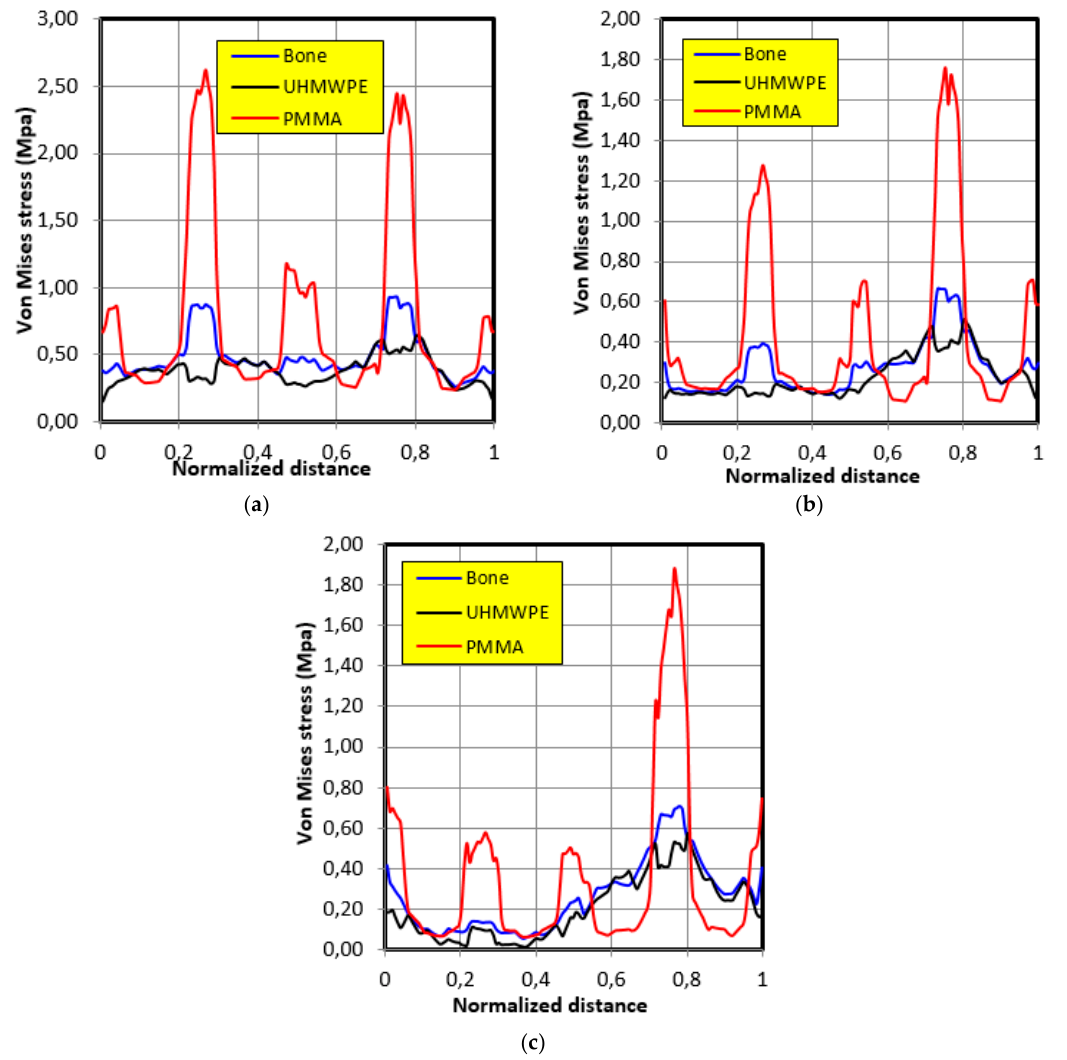
Figure 11. The Von Mises stresses distribution along the graft contour in the case of movement of individual 2. ( a ) 30° position; ( b ) 60° position; ( c ) 90° position.